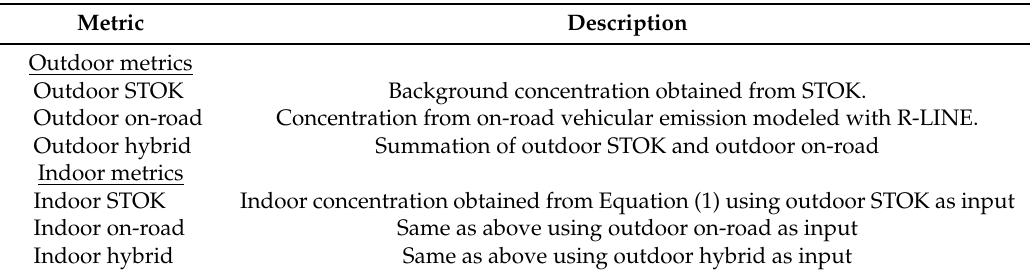
Table 1. Exposure metrics included in this